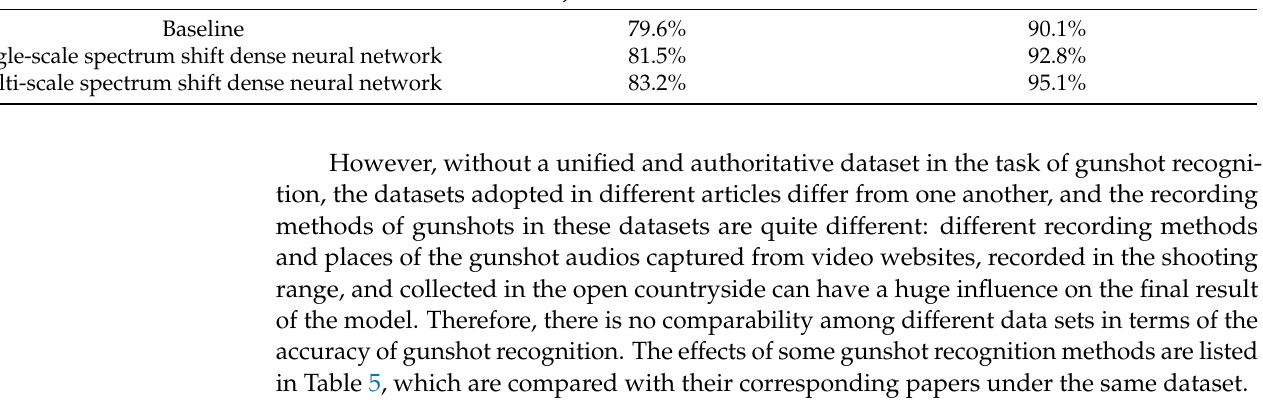
Table 5. Comparison of effects of multiple gunshot recognition networks.